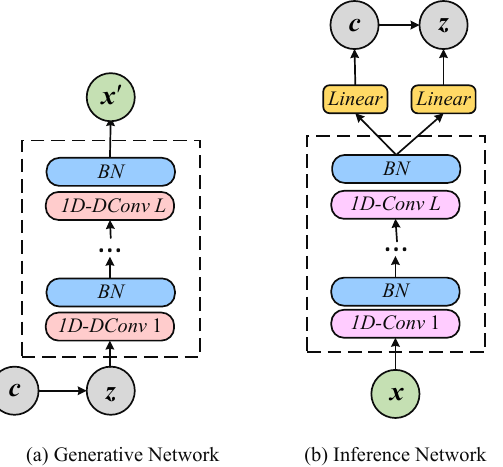
Figure 4. Network architecture of GM-CVAE, which is composed of two parts: ( a ) generative network and ( b ) inference network. x is the input data, and L is the layers of 1D-convolution and 1D-deconvolution. x (cid:48) is the reconstruction output, z and c are stochastic and categorical latent variables,